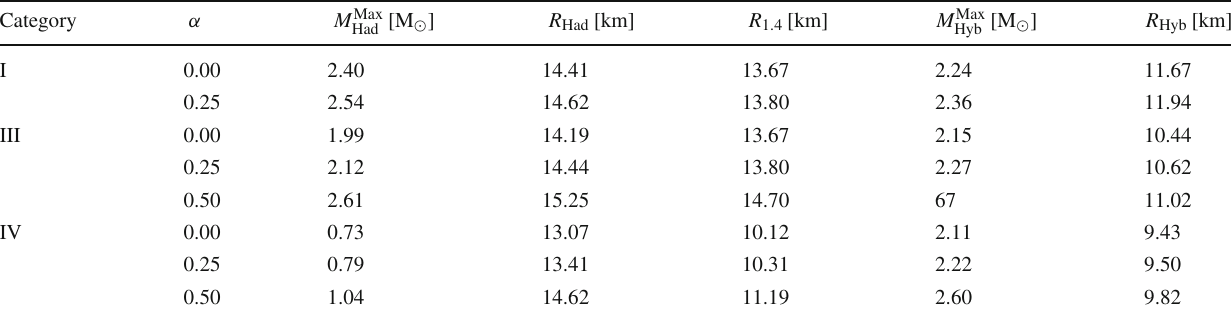
Table 1 Maximum gravitational masses for the hadronic (Had) and hybrid (Hyb) configurations with corresponding radii for the distinct categories of the CSS model Category α